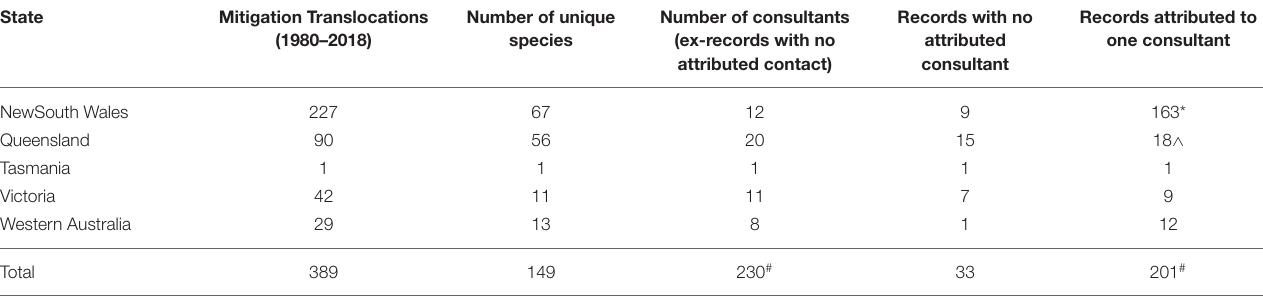
TABLE 1 | Summary of mitigation translocations recorded in the Translocation Database including records of all commenced translocations, regardless of completion.